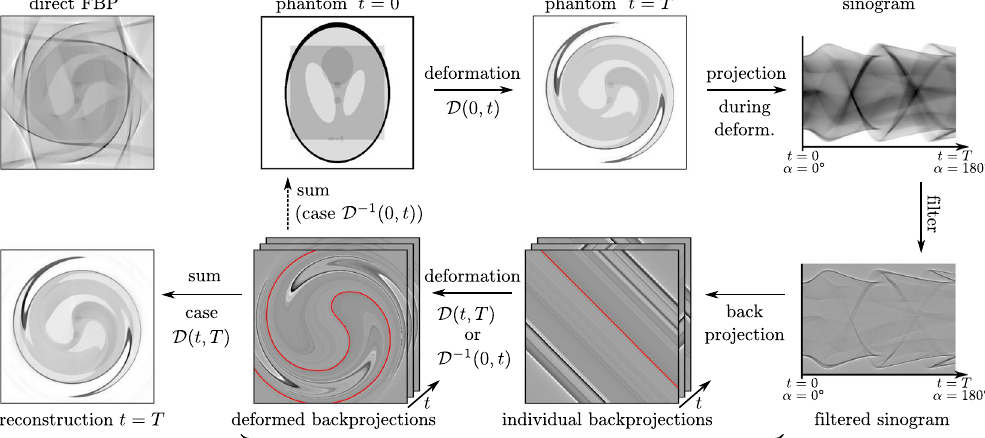
Figure 2. Scheme of the filtered backprojection on dynamically curved paths. The phantom is deformed as a function of time during the measurement, resulting in an inconsistent sinogram (upper row). While the conventional filtered backprojection yields a heavily hampered reconstruction (top left), the bottom row illustrates the new method, revealing a substantially improved reconstruction quality by incorporating the (known) temporal deformation. From the filtered sinogram, each individual back projection is deformed to a different degree (see text for details). The conventional straight back projection path is replaced by a dynamically curved path, as indicated by the highlighted red line. The superposition of all deformed backprojections results in a consistent representation of the phantom. As we show below, the motion model required for the dynamically curved paths can be estimated directly from the